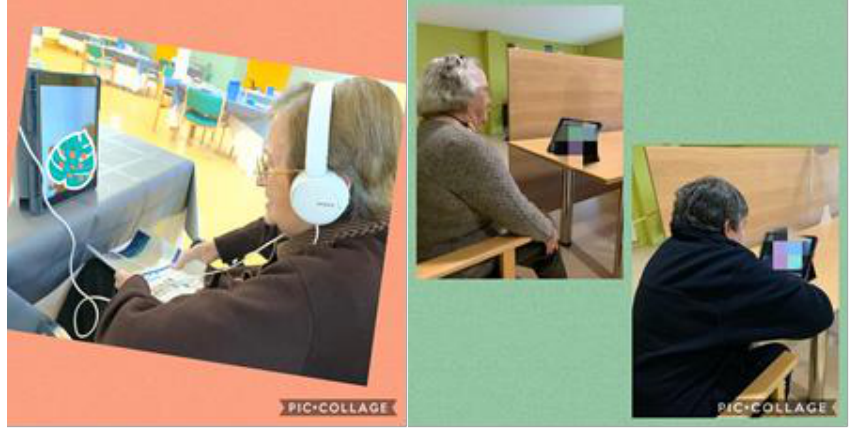
Figure 1. Video call